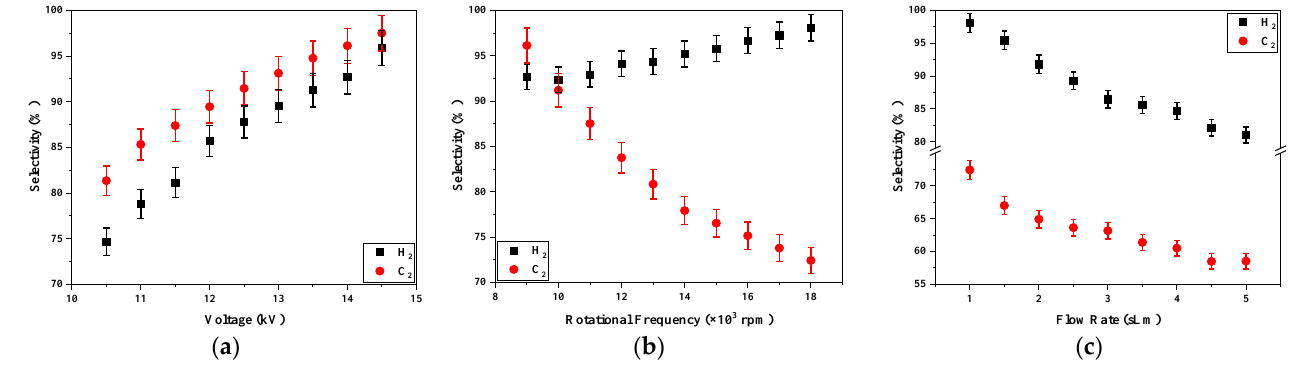
Figure 6. The selectivities of H 2 and C 2 versus ( a ) different voltages applied on the stationary power electrode at 1 sLm gas flow rate, ( b ) rotation frequencies of power electrode at 14 kV applied voltage and 1 sLm gas flow rate, and ( c ) gas flow rates at 14 kV applied voltage and 18,000 rpm rotation frequency of the power electrode.